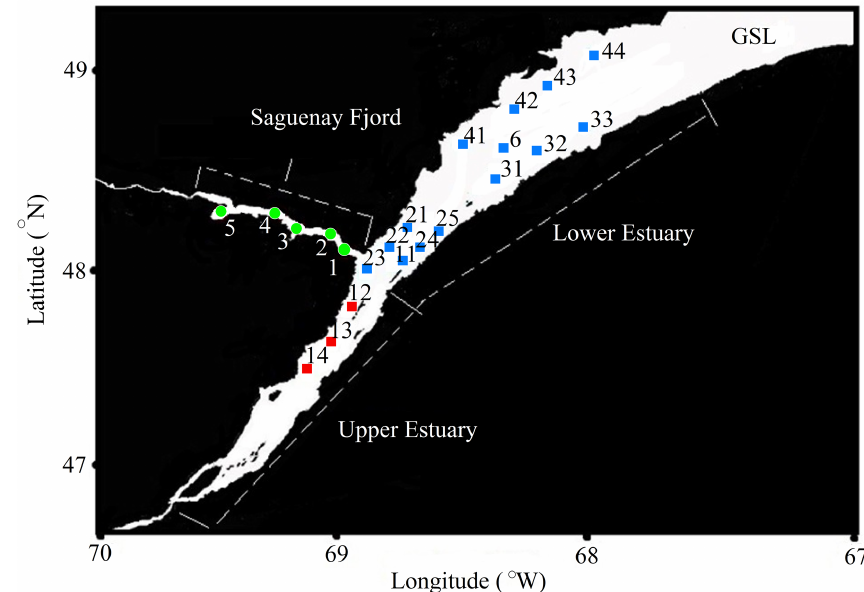
Figure 1. Study area. UE (red triangles), SF (green circles) and LE (blue rectangles) sub-regions. GSL is the Gulf of St. Lawrence.